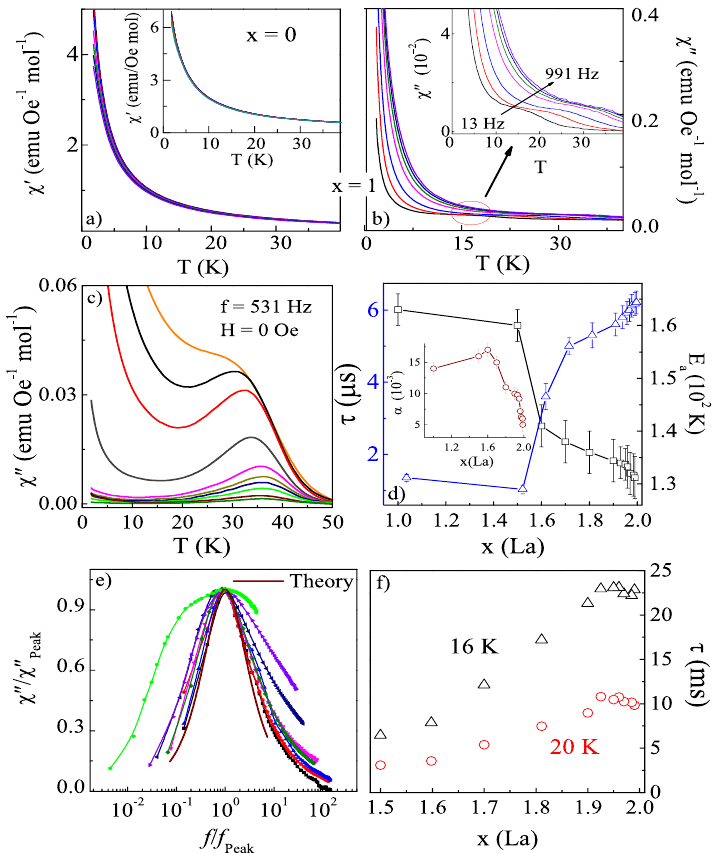
Figure 5. ( a – c ) The real χ ′ and imaginary χ ′′ parts of ac susceptibility for Dy 2 − x La x Zr 2 O 7 (0 ≤ x ≤ 1.99) measured at H dc = 0 Oe for frequencies ranges between f = 13–991 Hz. ( d ) Variation of E a and relaxation time τ for 1 ≤ x ≤ 1.99. Inset shows the variation in Cole–Cole parameter α . ( e ) Casimir-du Pré relation fit for ac susceptibility ( f ) Relaxation time τ = 1 / 2 π f vs x determined from the frequency of χ ′′ for 1.5 ≤ x ≤